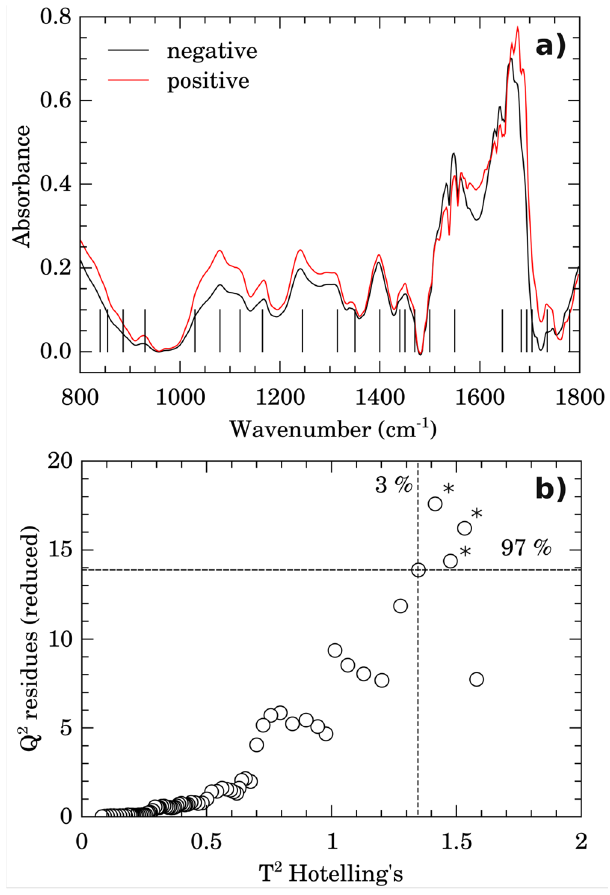
Figure 2. Average spectra and outliers. (a) Average micro-FTIR blood serum spectra for negative (black line) and positive (red line) groups. The vertical lines represents the main vibrational bands contributing to 2 discrimination of groups (see band assignments on Table 2). (b) Outliers identification by inspection of Q 2 residuals (reduced) versus T Hotelling’s. The outliers were indicated by “*”. Dashed horizontal lines and vertical 2 lines represent confidence limits of 3% (Hotelling’s T ) and 97% ( Q residuals),